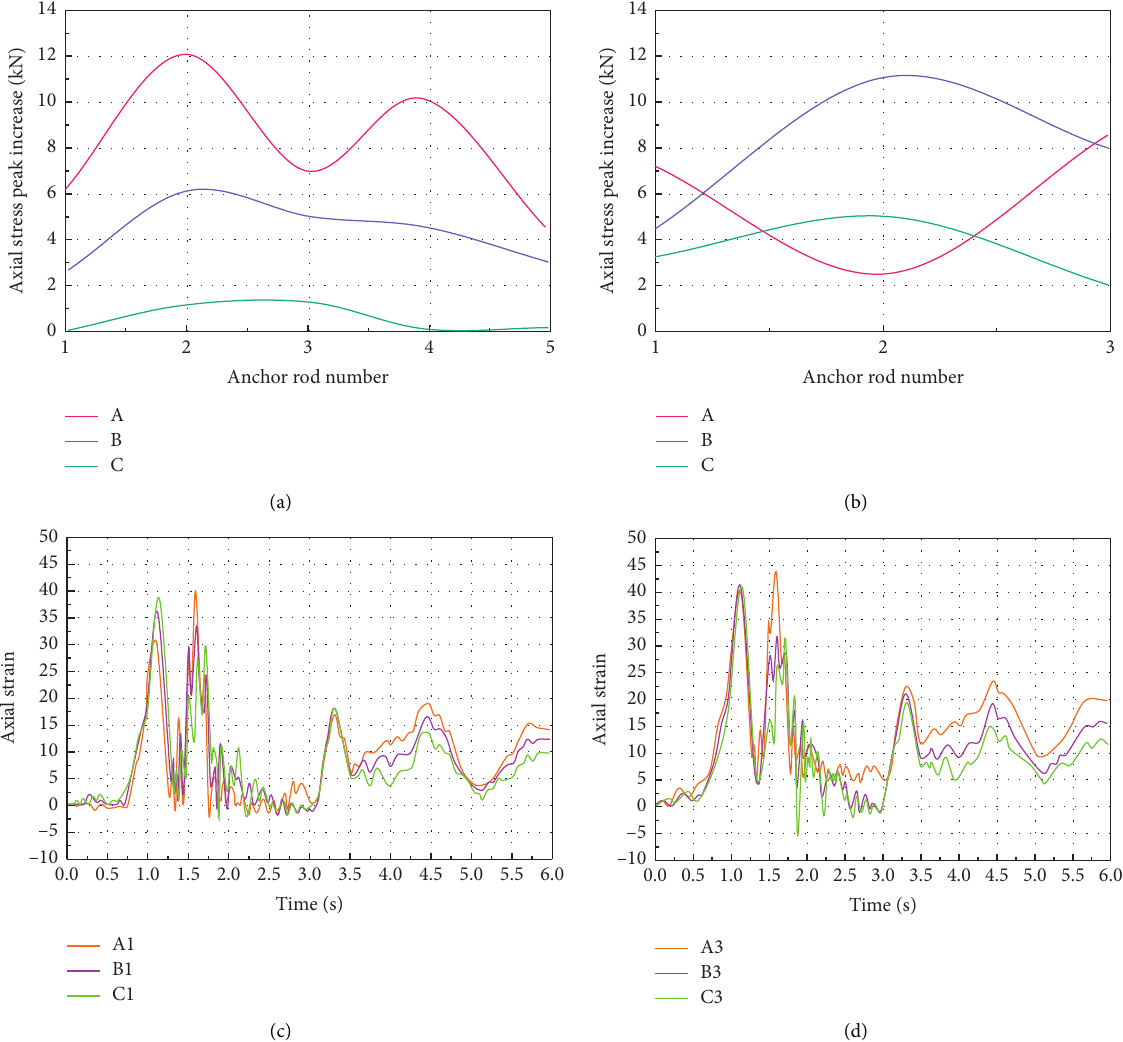
Figure 12: Stress increment curve of each bolt and strain time history curve of some bolts: (a) axial stress increment curve of each bolt in roadway side; (b) axial stress increment curve of each bolt of roof; (c) time history curve of axial strain of No.1 bolt; (d) time history curve of axial strain of No. 3